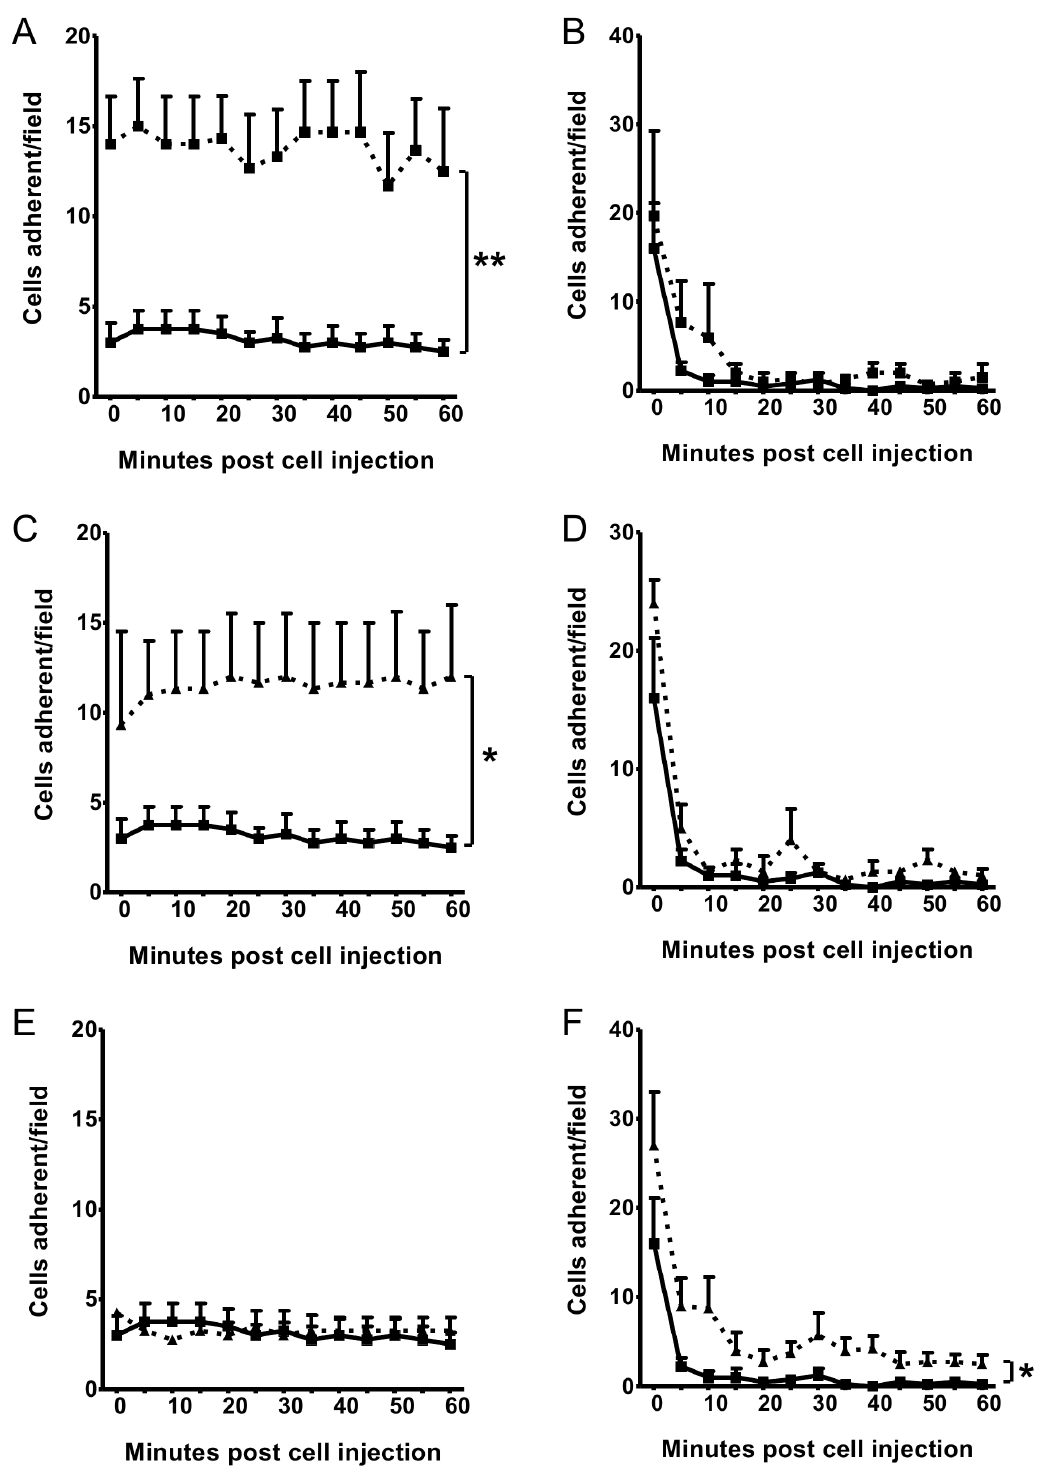
Figure 6. Topical treatment of the small intestine with cytokines increases HPC-7 adhesion invivo . (A) Mucosal treatment with TNF- a significantly enhanced adhesion of HPC-7 cells in vivo . (B) No increase in free-flowing HPC-7 was observed following topical treatment of the gut with TNF- a . (C) Mucosal treatment with IL-1 b significantly enhanced adhesion of HPC-7 cells in vivo. (D) No increase in freeflowing HPC-7 was observed following topical treatment of the gut with IL-1 b . (E) No increase in adhesion was observed following topical treatment of the gut with CXCL12. (F) Significantly increased numbers of HPC-7 were observed free-flowing through the gut following topical CXCL12 treatment. Results are represented as mean cells adherent/field 6 SEM (n $ 3/group); * p , 0.01, ** p , 0.01, PBS topical treatment vs Cytokine topical treatment.